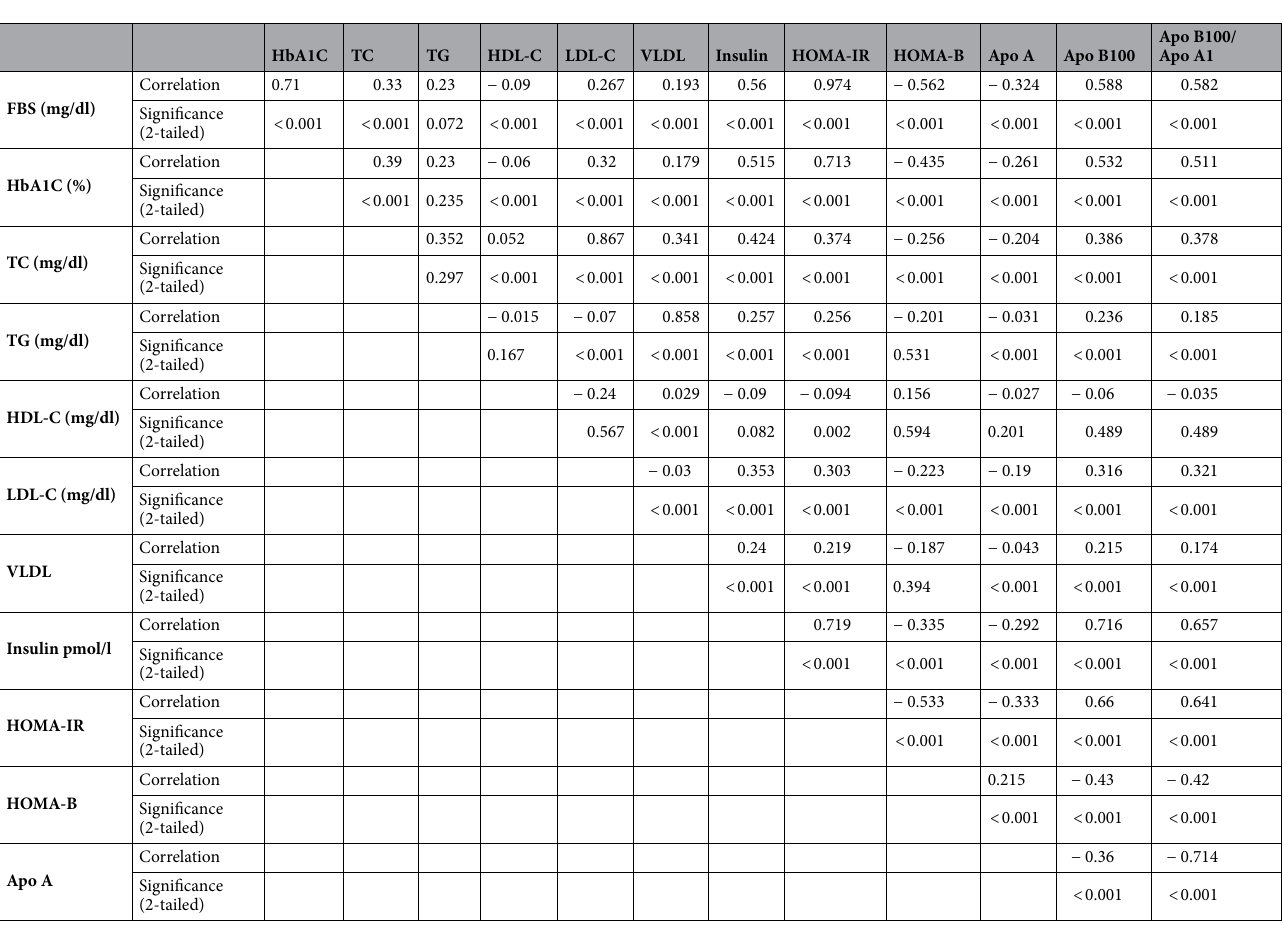
Table 2. Correlation between glycemic profile, lipid profile and apolipoproteins in type 2 diabetes mellitus. * P value ≤ 0.05 was considered statistically